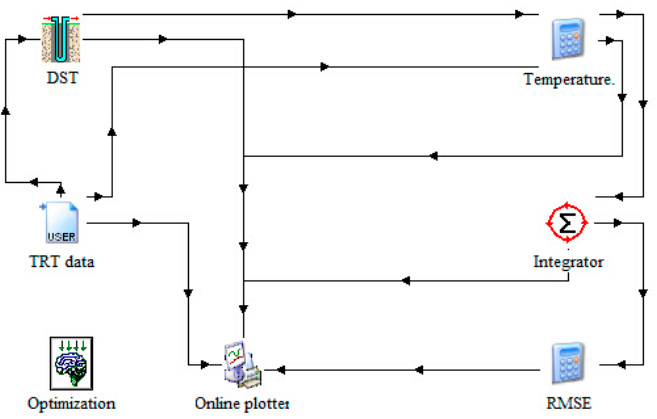
Figure 3. Layout of the DST-based PE approach.